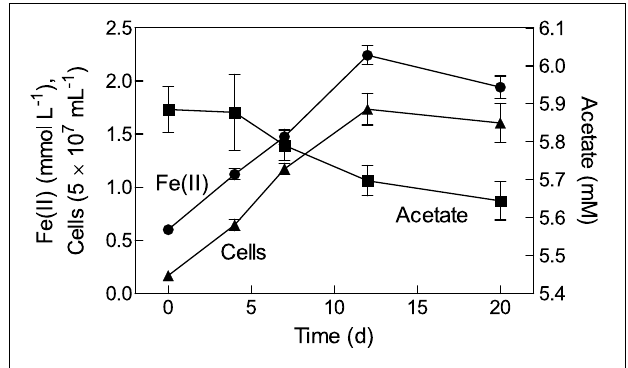
FIGURE 1 | Growth of Geobacter bremensis strain R1 with NAu-2 smectite as the electron acceptor and acetate as the electron donor. Data represent mean ± SD of triplicate cultures.